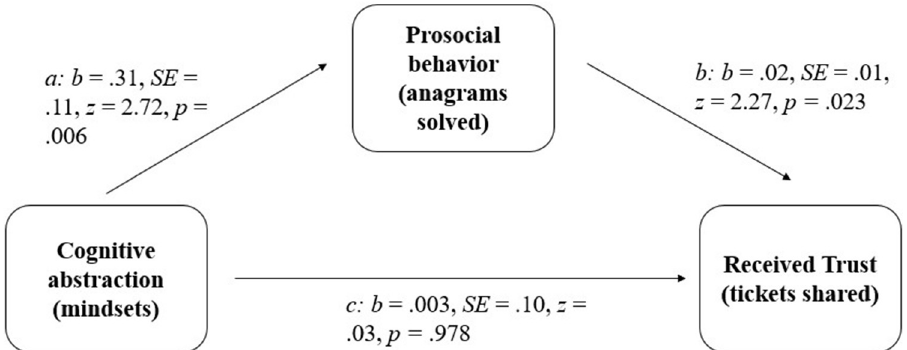
Fig 3. Path model for Study 2 (parameter estimates based on negative binomial